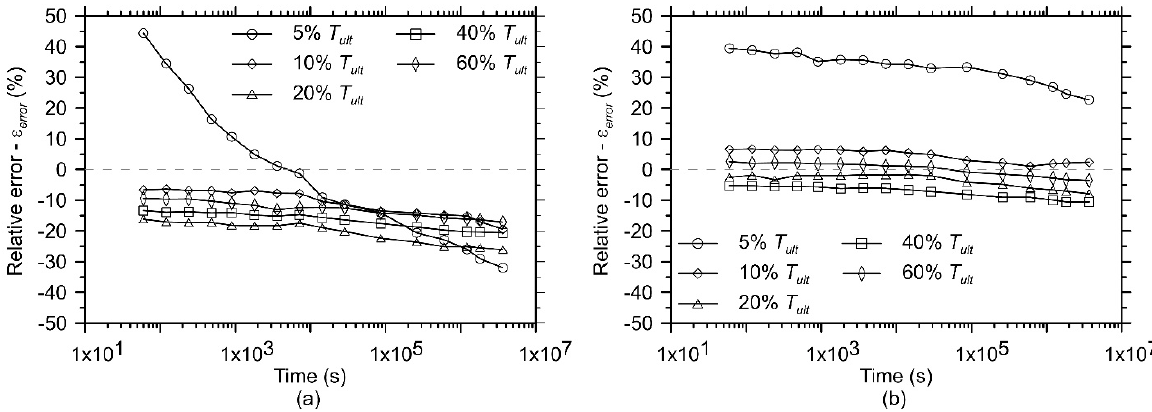
Figure 6. Relative strain error between the mean axial strains obtained from the accelerated creep test and the mean axial strains obtained from the conventional creep test at all load levels applied in the test program for ( a ) GTXnwC and ( b ) GTXnwS.